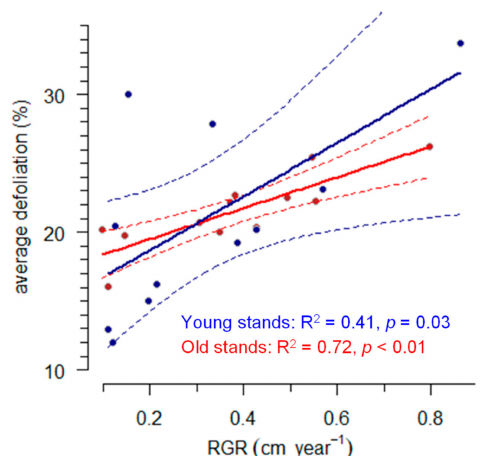
Figure 6. Lineal regression between the relative growth rate (RGR, calculated for the period 2001–2007) and average defoliation in 2017 of young (blue lines and symbols) and old (red lines and symbols) Abies pinsapo trees. The dashed lines show the 95% prediction